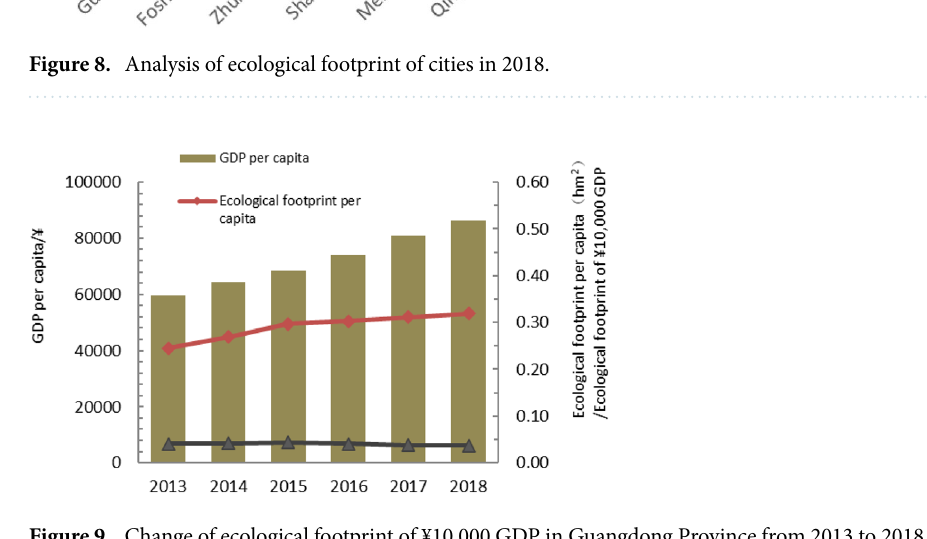
Figure 9. Change of ecological footprint of ¥10,000 GDP in Guangdong Province from 2013 to